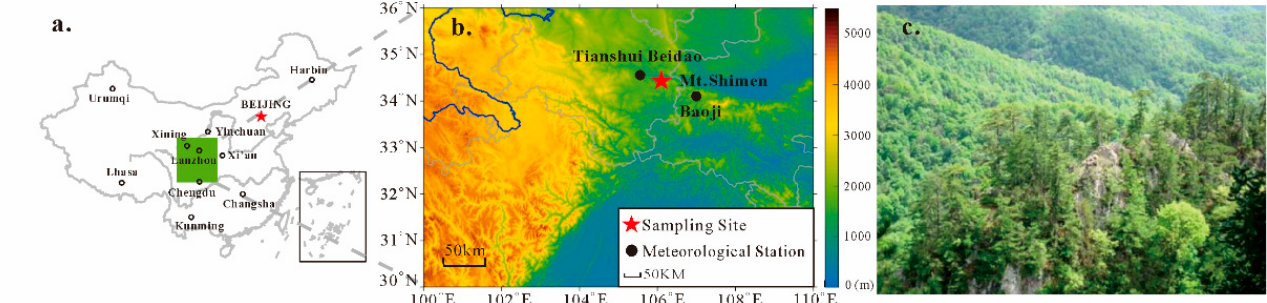
Figure 1. ( a ) The green area represents the location of the study area in China, ( b ) the distribution of tree-ring sampling site and adjacent meteorological stations, and ( c ) the photo of Mt. Shimen. In this study, Mt. Shimen located on the Loess Plateau was selected as the research site, and P. tabulaeformis in its forest system was collected to establish tree-ring width, δ 13 C, and iWUE series. The variability and characteristics of these three time series are compared. The effects of rising atmospheric CO 2 concentrations and climate change on the tree-ring